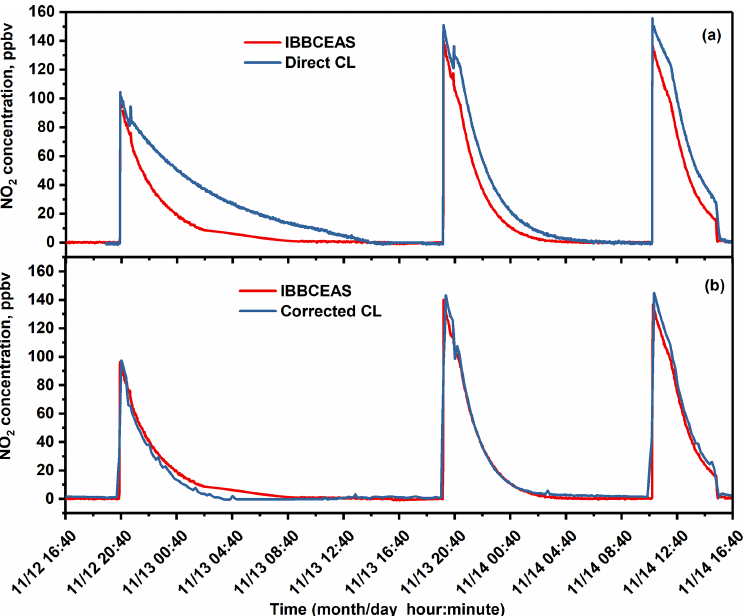
Figure 6. Investigation of positive interferences from nitrogen-containing species (here HONO) in the NO x analyser (CL) measurement in comparison to the UV-LED-IBBCEAS measurement: (a) from CL-NO x analyser without HONO correction; (b) CL-NO x analyser results after HONO correction.